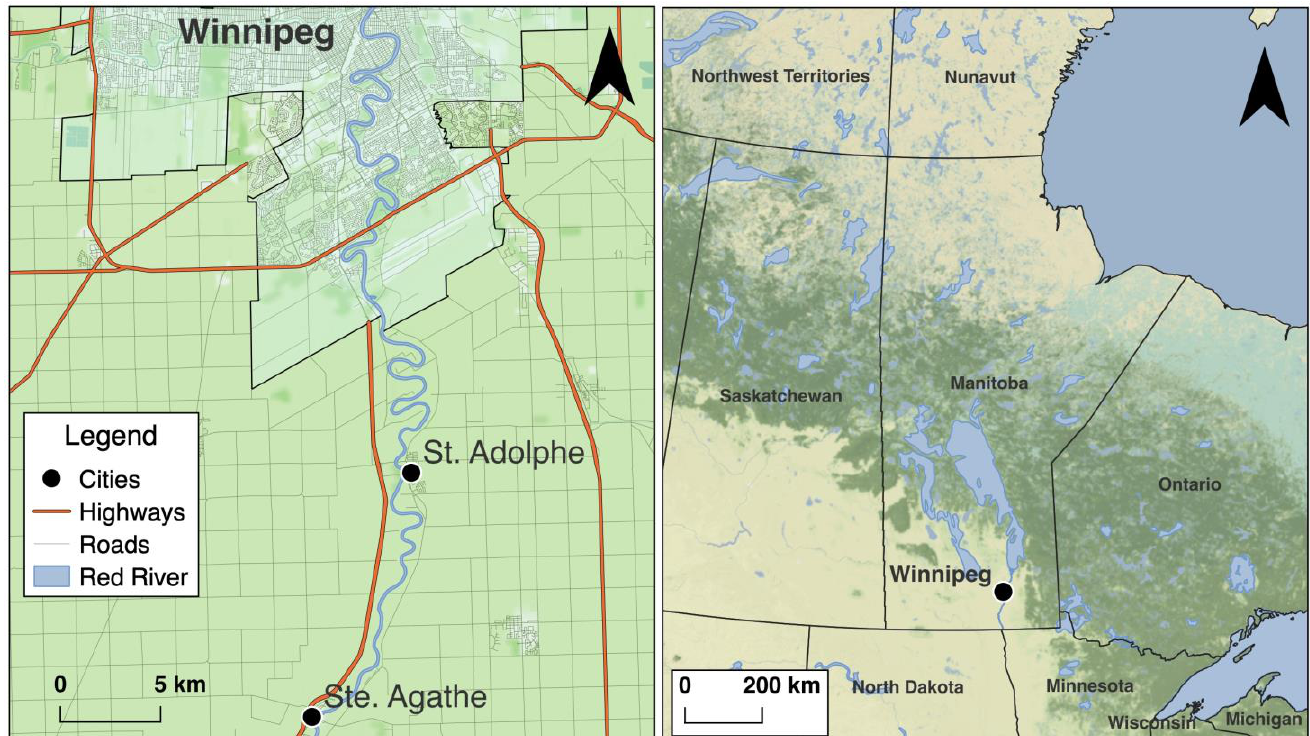
Figure 3. Map of Manitoba showing the locations of St. Adolphe and Ste. Agathe and location in Canada (Map tile background by Stamen Design, under Creative Commons BY 3.0. Data by OpenStreetMap, under ODbL.).